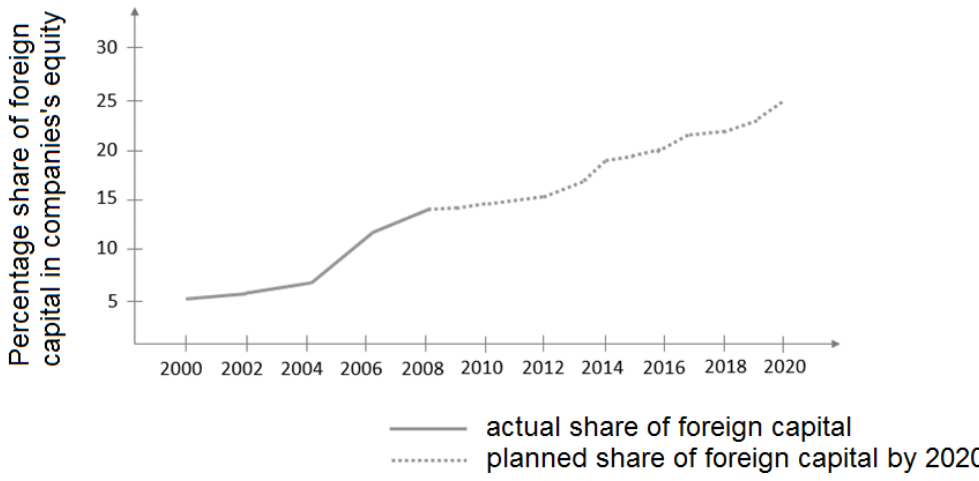
Figure 2. The percentage share of foreign capital in firms’ equity, actual for the period 2000 to 2008, and planned by 2020. (Source: Own study).